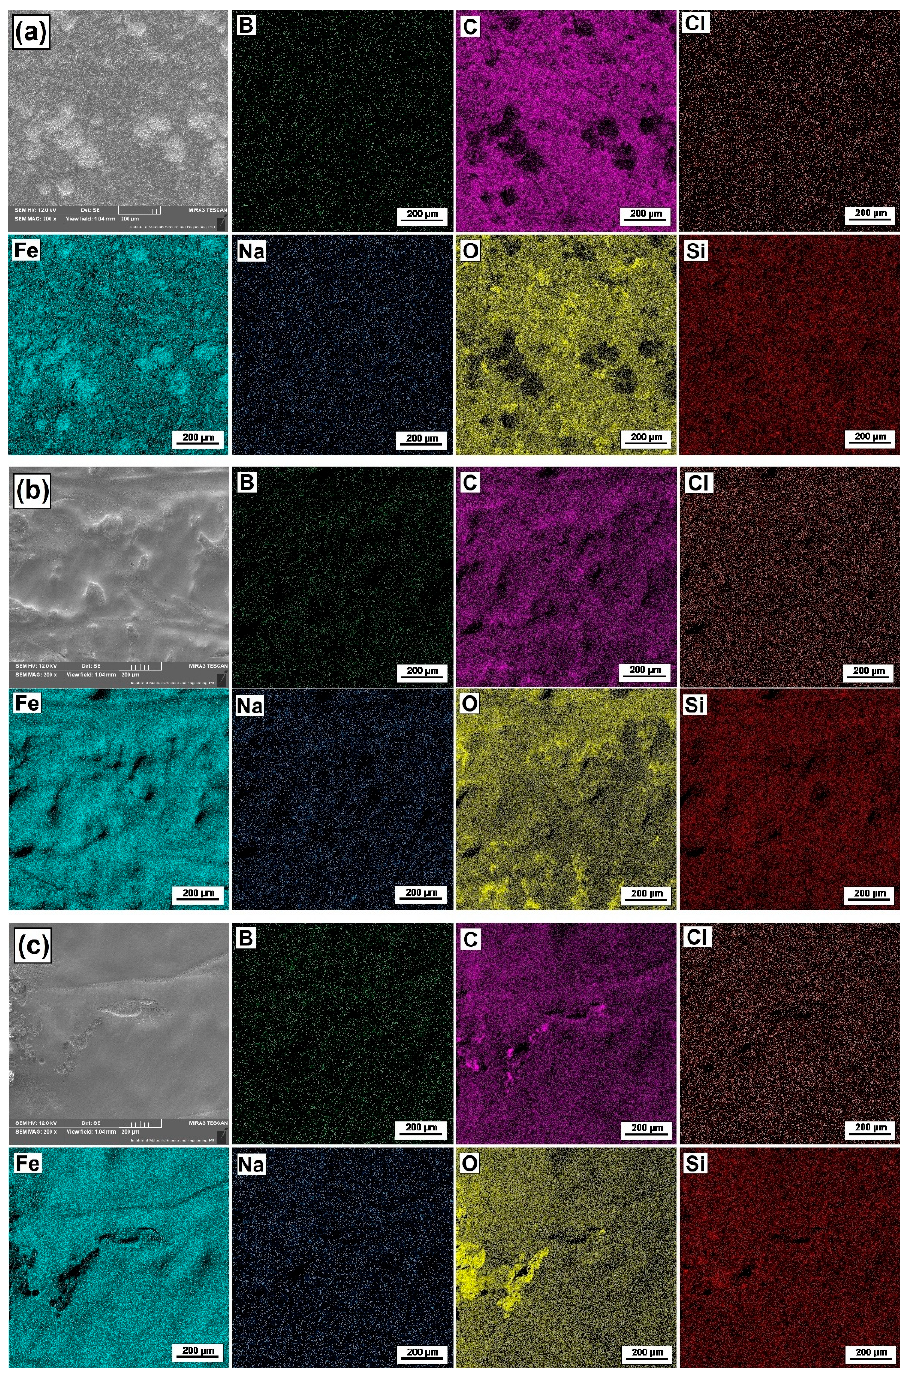
Figure 10. Surface condition and EDS mappings results of produced composite coatings after corrosion tests: ( a ) Fe–B coating (#1 laser beam parameters); ( b ) Fe–B–B 4 C–Si coating (#3 laser beam parameters); ( c ) Fe–B–B 4 C–Si coating (#5 laser beam parameters); (specimens numbers in accordance with Table